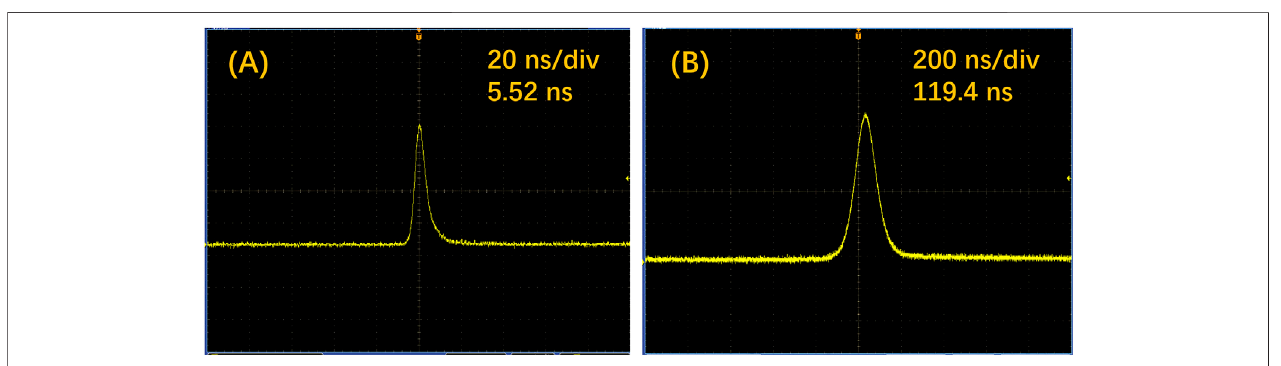
FIGURE 6 | The temporal pro fi les of Q-switching pulses at the pump power of 8 W: (A) double Q-switching; (B) single SnSe 2 SA Q-switching.